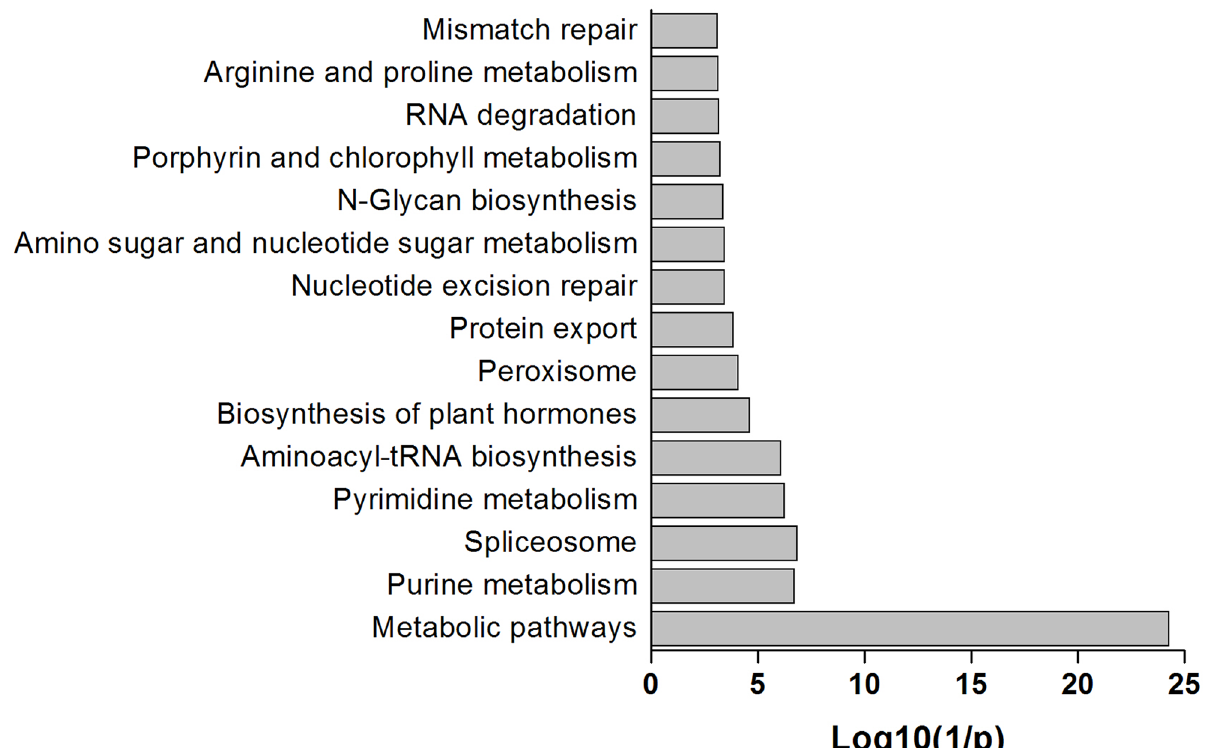
Fig 4. Results of KEGG pathway enrichment analysesof 6,689 orthologous genes in B . humilis . KEGG pathway enrichment was analyzedusing the PlantGSEA program and the cutoff value of FDR was 0.05.